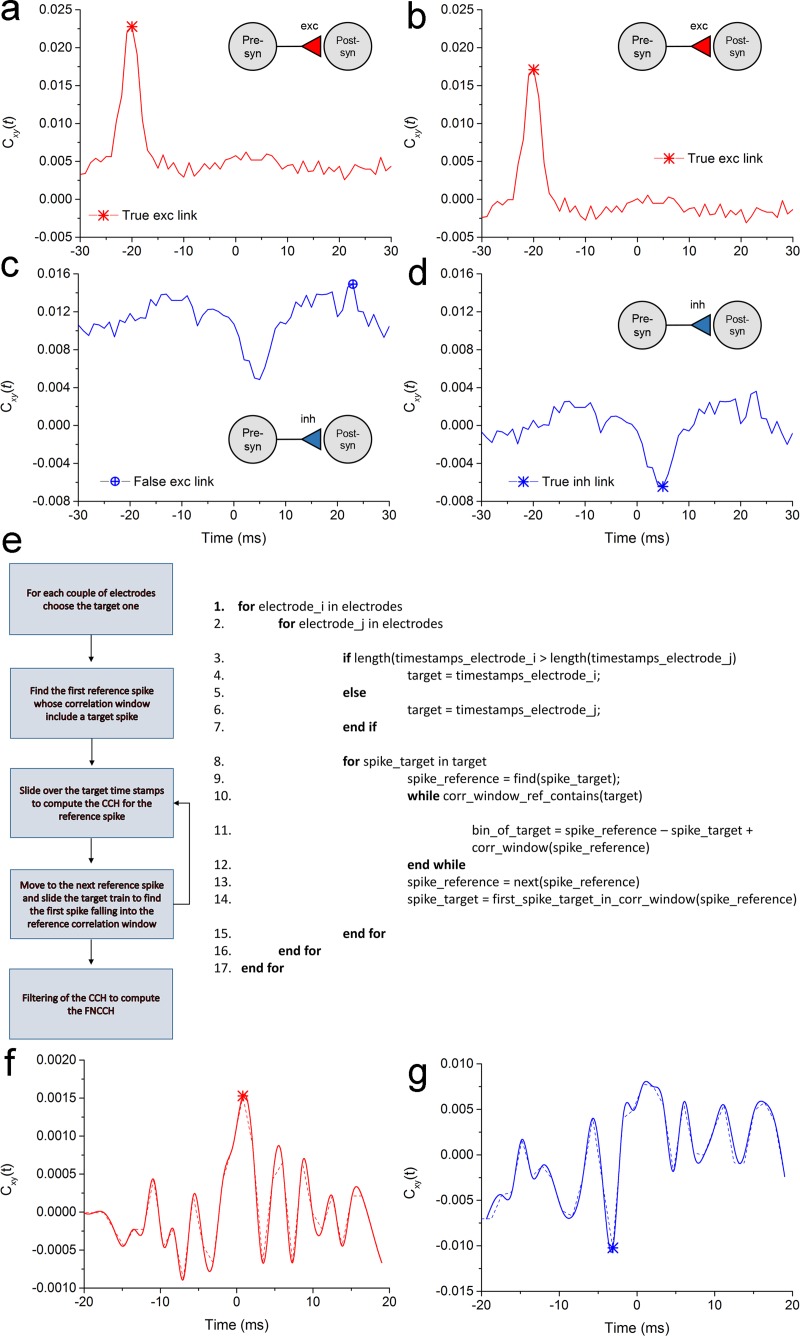
Example of detection for excitatory and inhibitory links in a network model.a, NCCH computed between two spike trains related to two neurons linked by an excitatory link in the model (identified by a red asterisk). b. FNCCH of the two neurons of panel a. The “entity peak” allows a better recognition of the excitatory link. c. NCCH computed between two spike trains related to two neurons linked by an inhibitory link in the model. The NCCH might detect a false excitatory peak (blue cross). d, FNCCH of the two neurons of panel c. The filtering procedure allows to recognize the through and to detect the negative peak correspondent to the inhibitory link (blue asterisk). e. Schematic representation and description of the algorithm to obtain the FNCCH. f. FNCCH (dashed line) for two putative neurons connected by a putative excitatory connection. g. FNCCH (dashed line) for two putative neurons connected by a putative inhibitory connection. The continuous lines in panels f and g are a smoothing of the histogram (dashed lines).